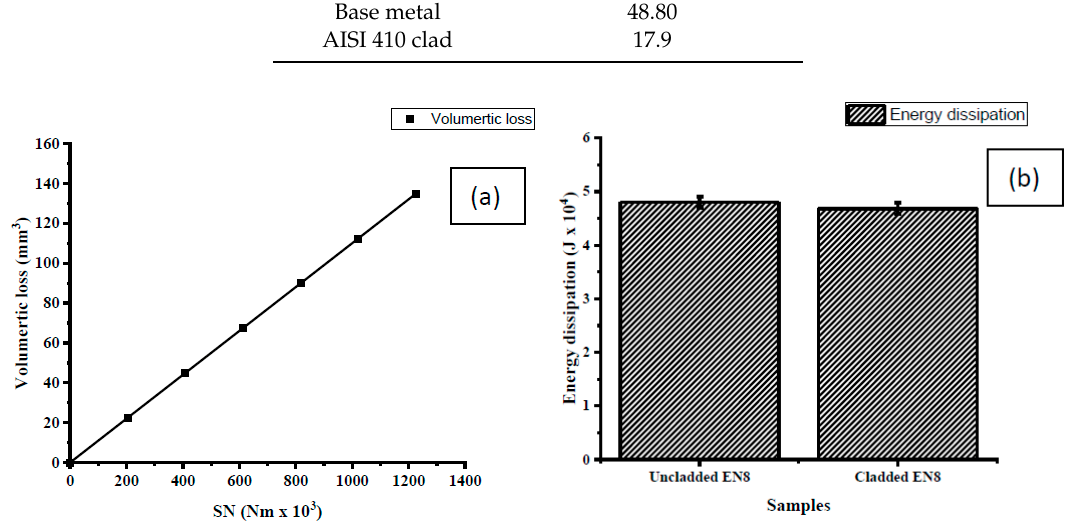
Figure 10. ( a )Volumetric loss vs. Speed-normal load SN curve of AISI-410 Clad (based on Archard analysis) after each 600 s of test till 3600 s, and ( b ) Bar plot showing energy dissipation uncladded EN 8 (base metal) and AISI 410 cladded EN8 samples.